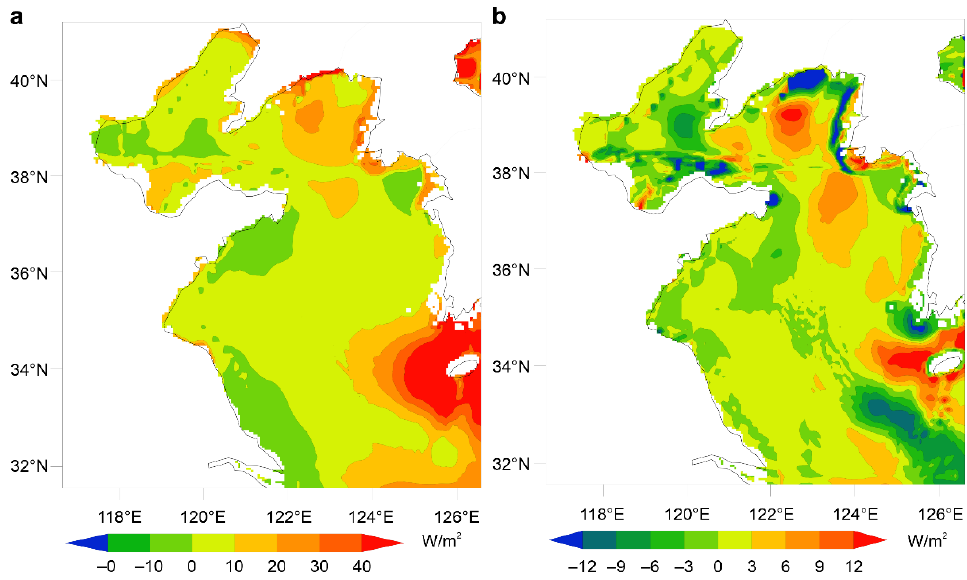
Figure 8. ( a ) CODAS sensible heat flux and ( b ) its difference with respect to FNL sensible heat flux at 00:00 on 20 February 2020 for 48-h forecasting.